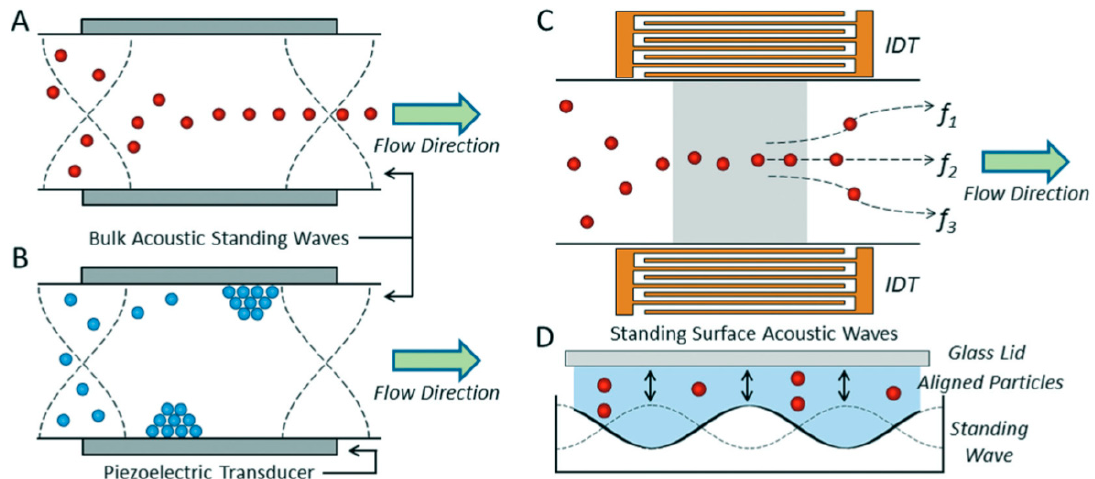
Figure 14. Acoustofluidic manipulations with particles and cells with a positive ( A ) and negative ( B ) acoustic response in a bulk acoustic standing wave. ( C ) The schematic of an surface standing acoustic waves (SSAW) device with interdigital transducers (IDTs) focusing the cells along well-defined streamlines. ( D ) The cross-section of an SSAW device with four pressure nodes. Reprinted with permission from [165]. Copyright 2015, Royal Society of